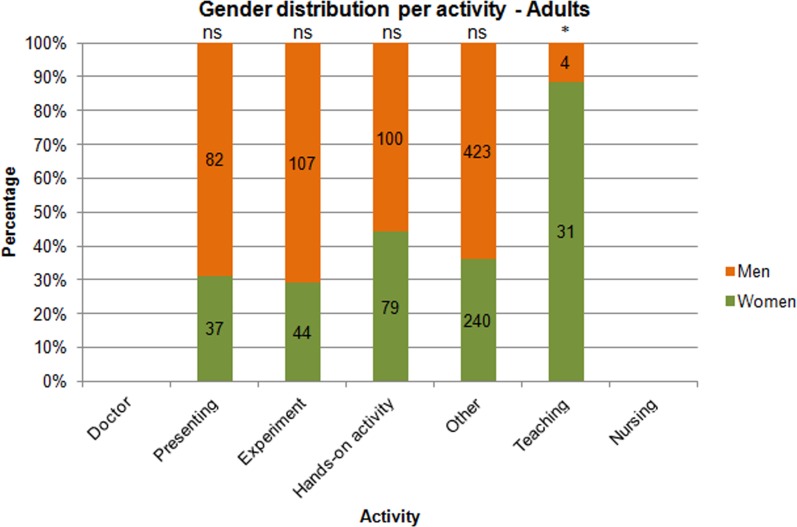
Gender distribution for activity type—Adults.N(people) = 1147. Note: * = p<0.001.